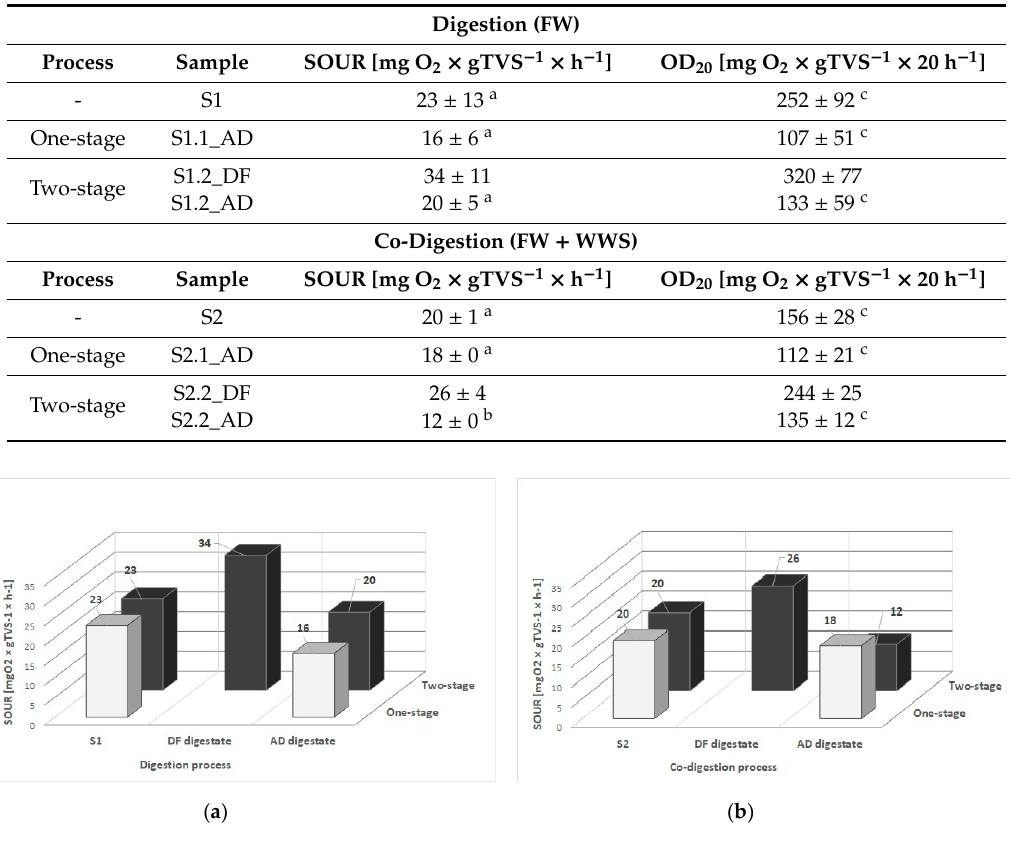
Figure 2. Stability index trend during one-stage and two-stage AD systems. Digestion process ( a ) and Co-digestion process ( b ) are reported.